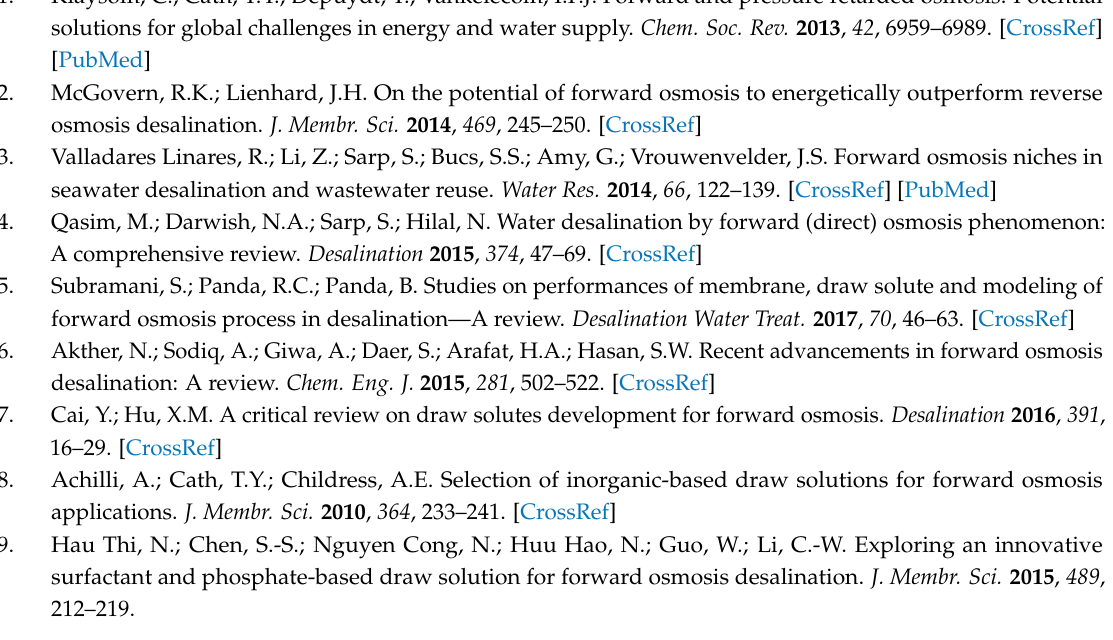
Figure S1: Hysteresis cycles of Fe 3 O 4 /PAANa nanocomposites obtained by oxidative precipitation expressed in Am 2 /Kg Fe, Figure S2: Thermogravimetric analysis of all samples showing the shift in the decomposition temperature of adsorbed PAANa. Figure S3: 3D Plot of the dependence of the hydrodynamic size on the magnetic particle size (d XRD ) and PAANa wt % content. Table S1: Comparison of the saturation magnetization per Kg of iron present in the composite samples of Fe 3 O 4 /PAANa obtained by oxidative precipitation with the reference samples of pure magnetite/maghemite of similar